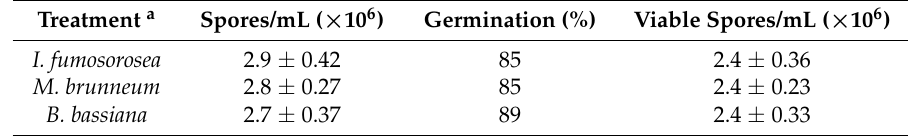
Table 1. Spore densities and viabilities of three entomopathogenic fungal suspensions.